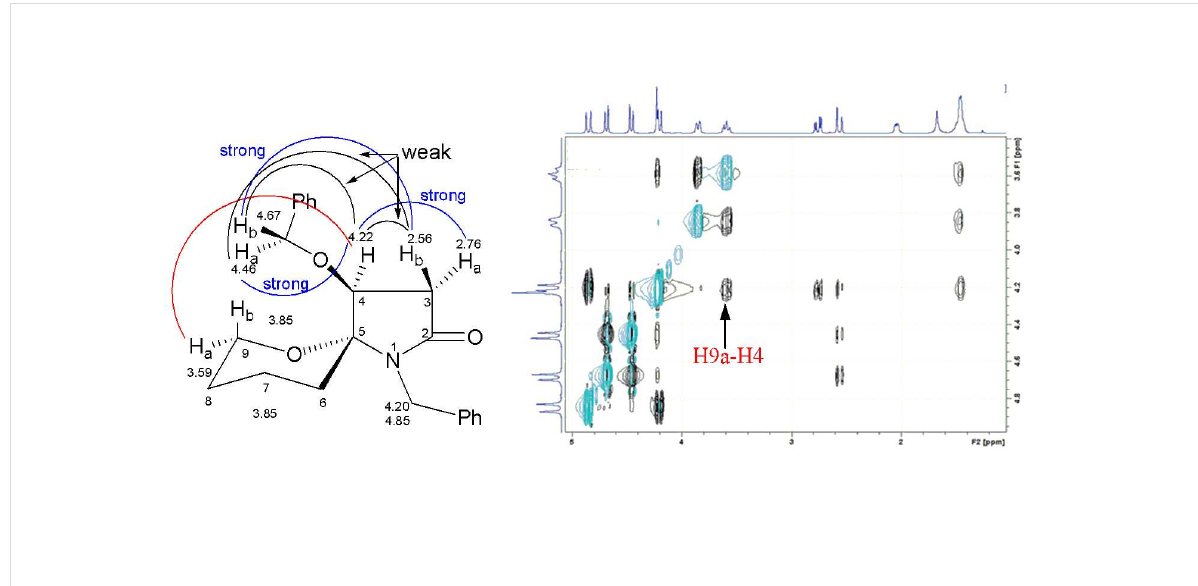
Figure 1: The observed NOE correlations (in part) and the region expanded NOESY spectrum of compound 7 .